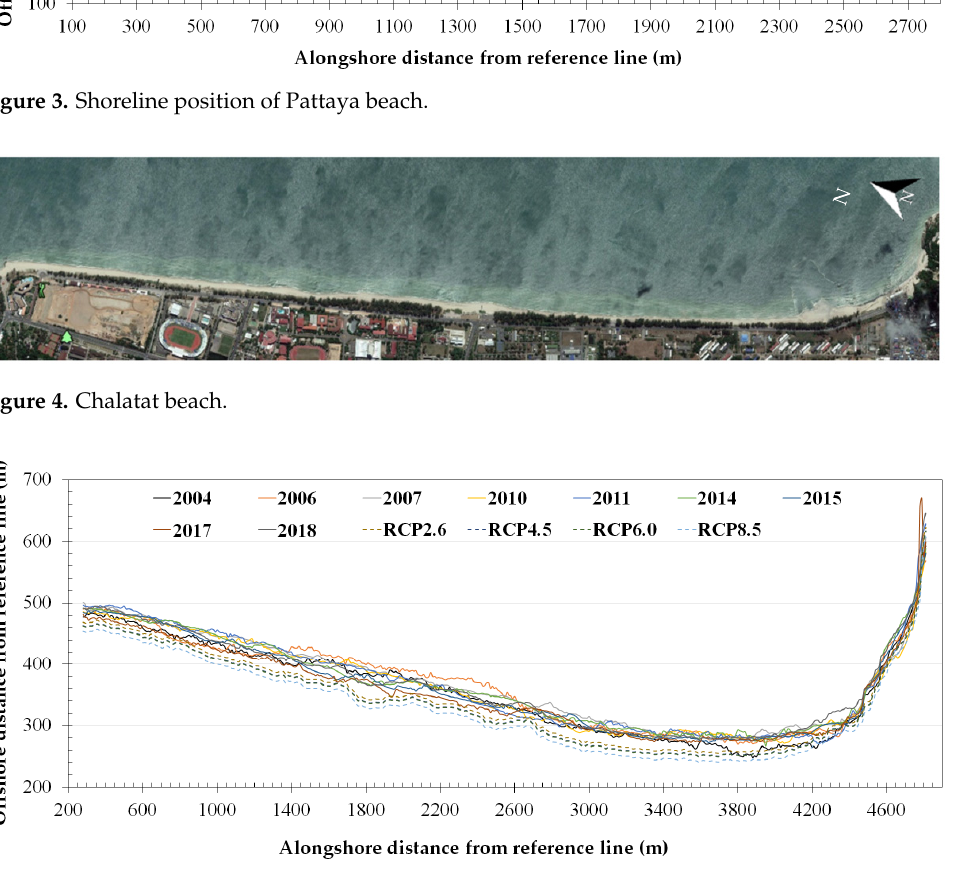
Figure 6. Rate of shoreline change at Pattaya beach.